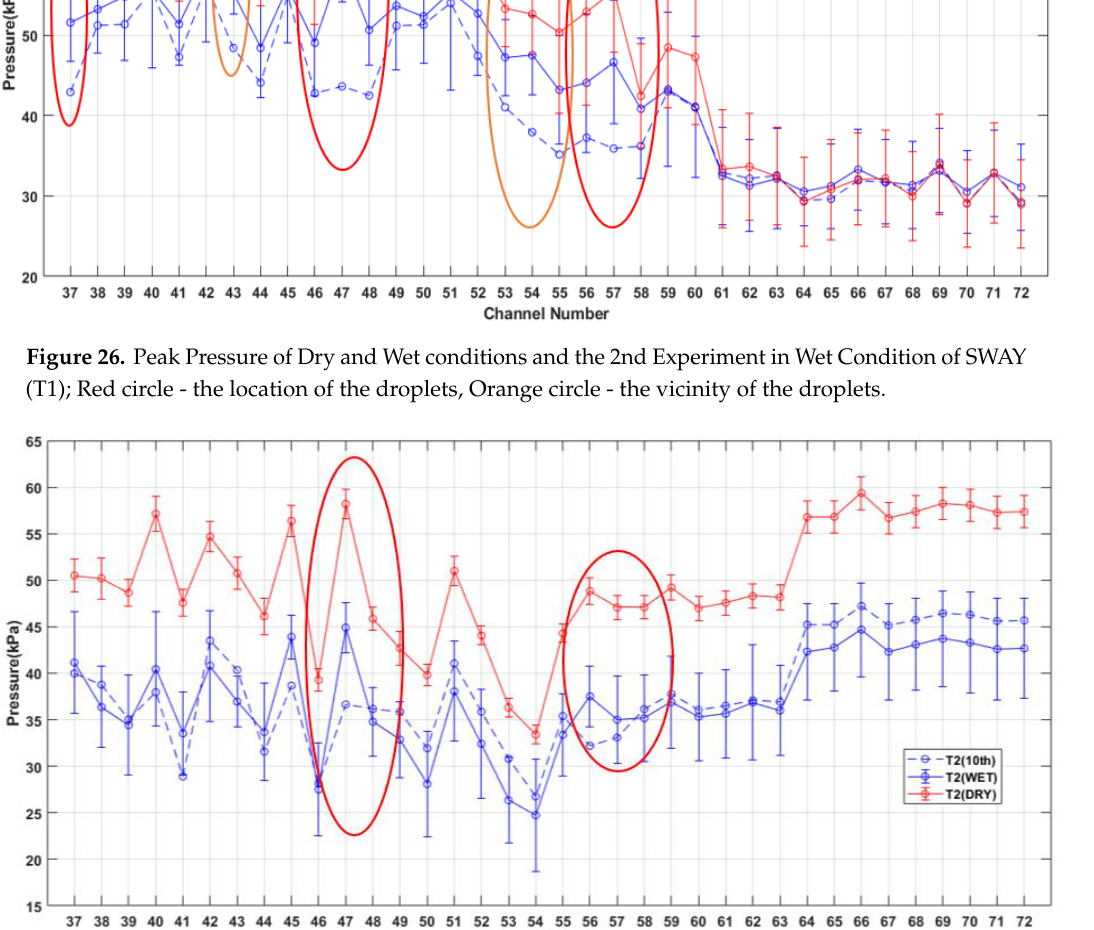
Figure 27. Peak Pressure of Dry and Wet conditions and the 10 th Experiment in Wet Condition of ROLL (T2); Red circle - the location of the droplets.